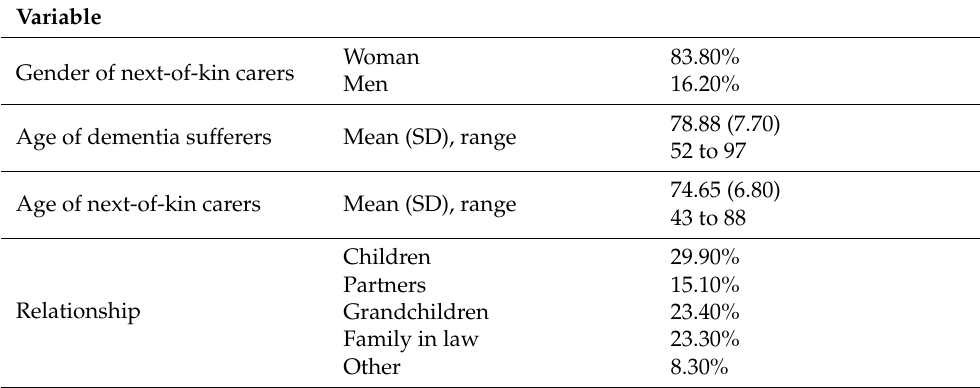
Table 1. Demographic characteristics of next-of-kin carers and dementia